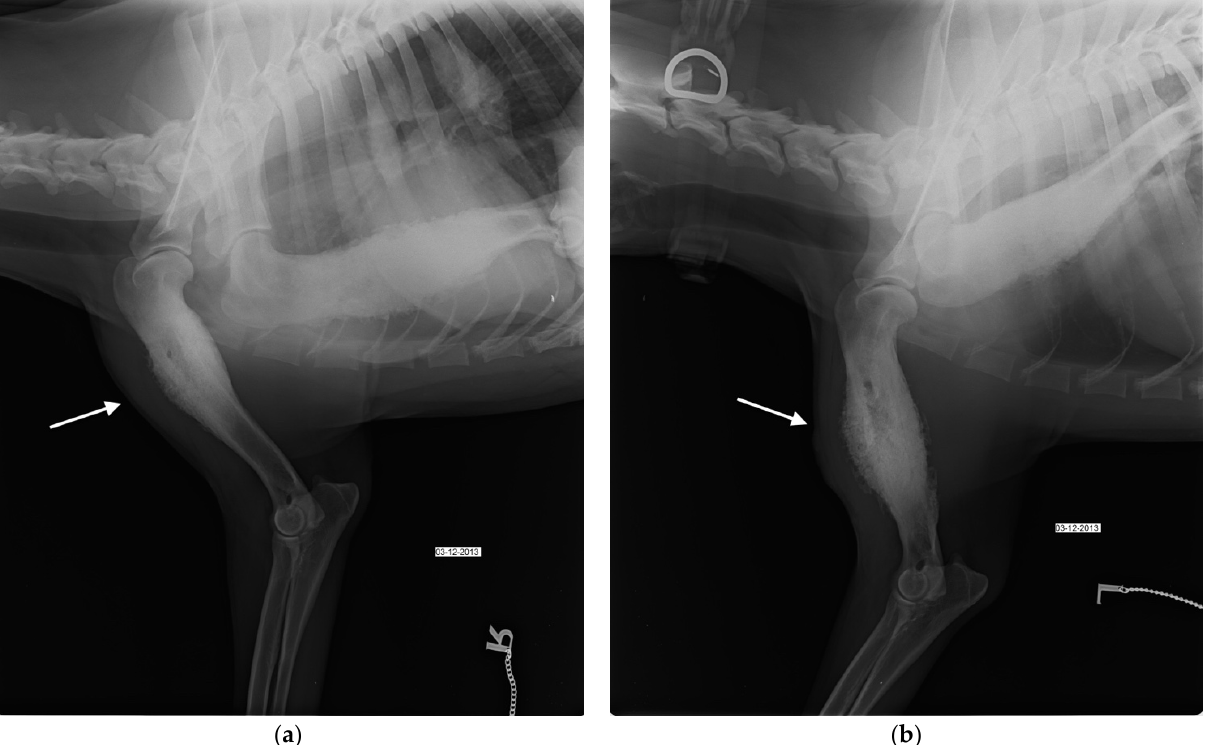
Figure 2. Right lateral (LL) thoracic radiograph at the day of first admission shows focal periosteal reaction of the 5th, 6th and 7th ribs (asterisk).